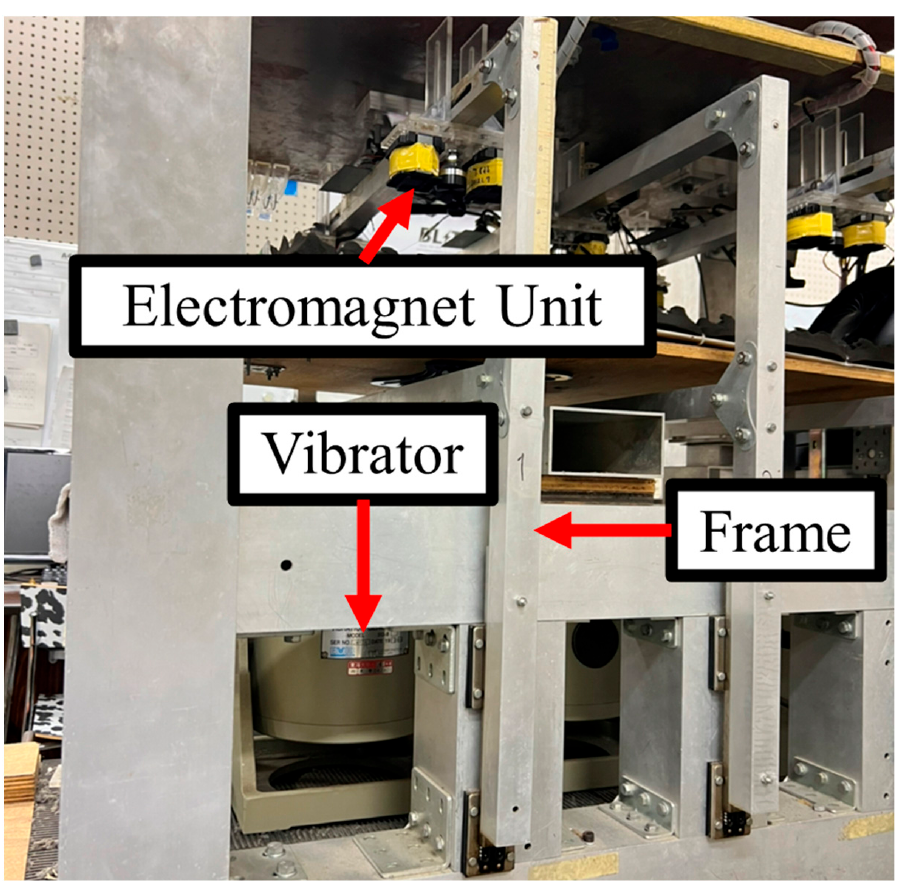
Figure 7. Photograph of the vibrators and frames.